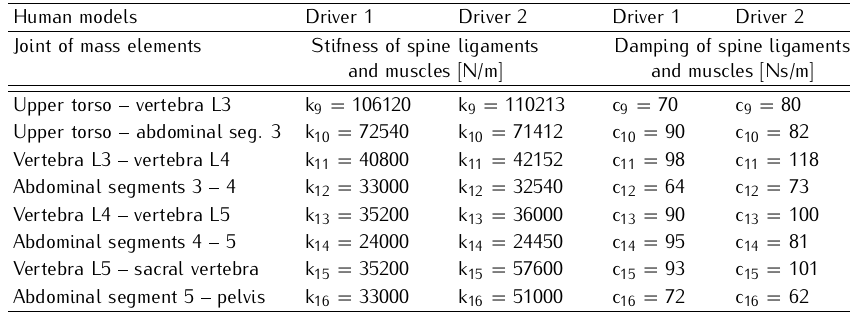
Table 3. Stiffness and damping of spine ligaments and muscles for two models of